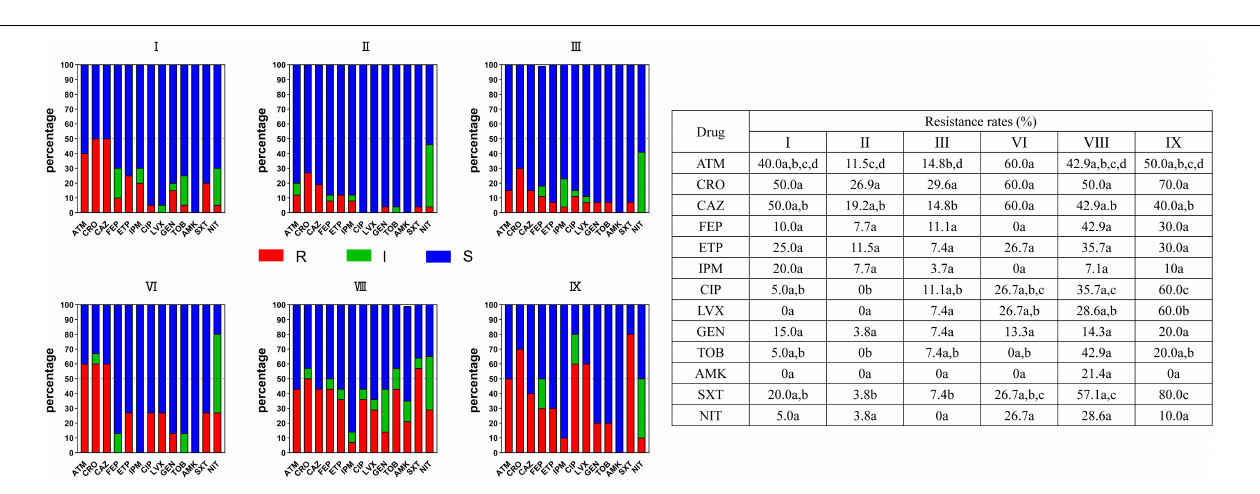
FIGURE 3 | Resistance of strains in six major clusters I, II, III, VI, VIII, and IX to commonly used clinical antibacterial drugs in ECC strains. Red squares indicate drug resistance, green squares indicate intermediation, and blue squares indicate sensitivity. One or more identical letters of a, b, c, and d in different cells indicate no statistical difference of resistance rate, while different letters of a, b, c, and d among the cells indicate a statistical difference. For example, for aztreonam, there is no difference in the resistance rate between I and VIII, II and IX, II and III, but a difference in resistance rate is observed between II and VI. ECC, Enterobacter cloacae complex; R, resistance; I, intermediation; S,